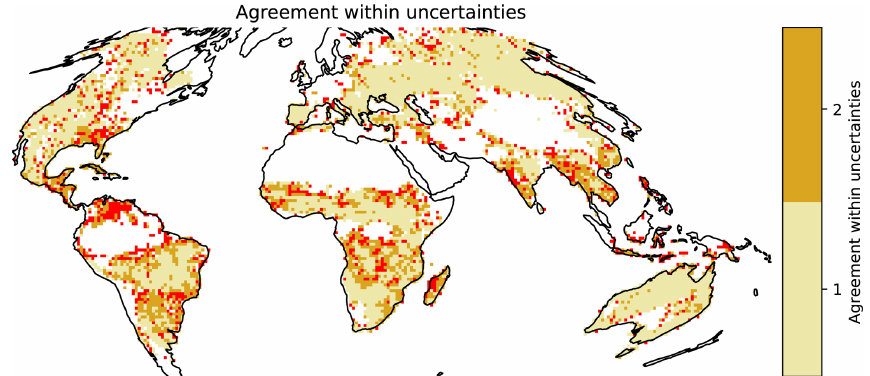
Figure 6. Consistency of mean annual burned area for the three products. Light brown regions correspond to regions where all three products agree within 1 standard error. Brown regions correspond to agreement within 2 standard errors. Red regions indicate areas which do not agree within 2 standard